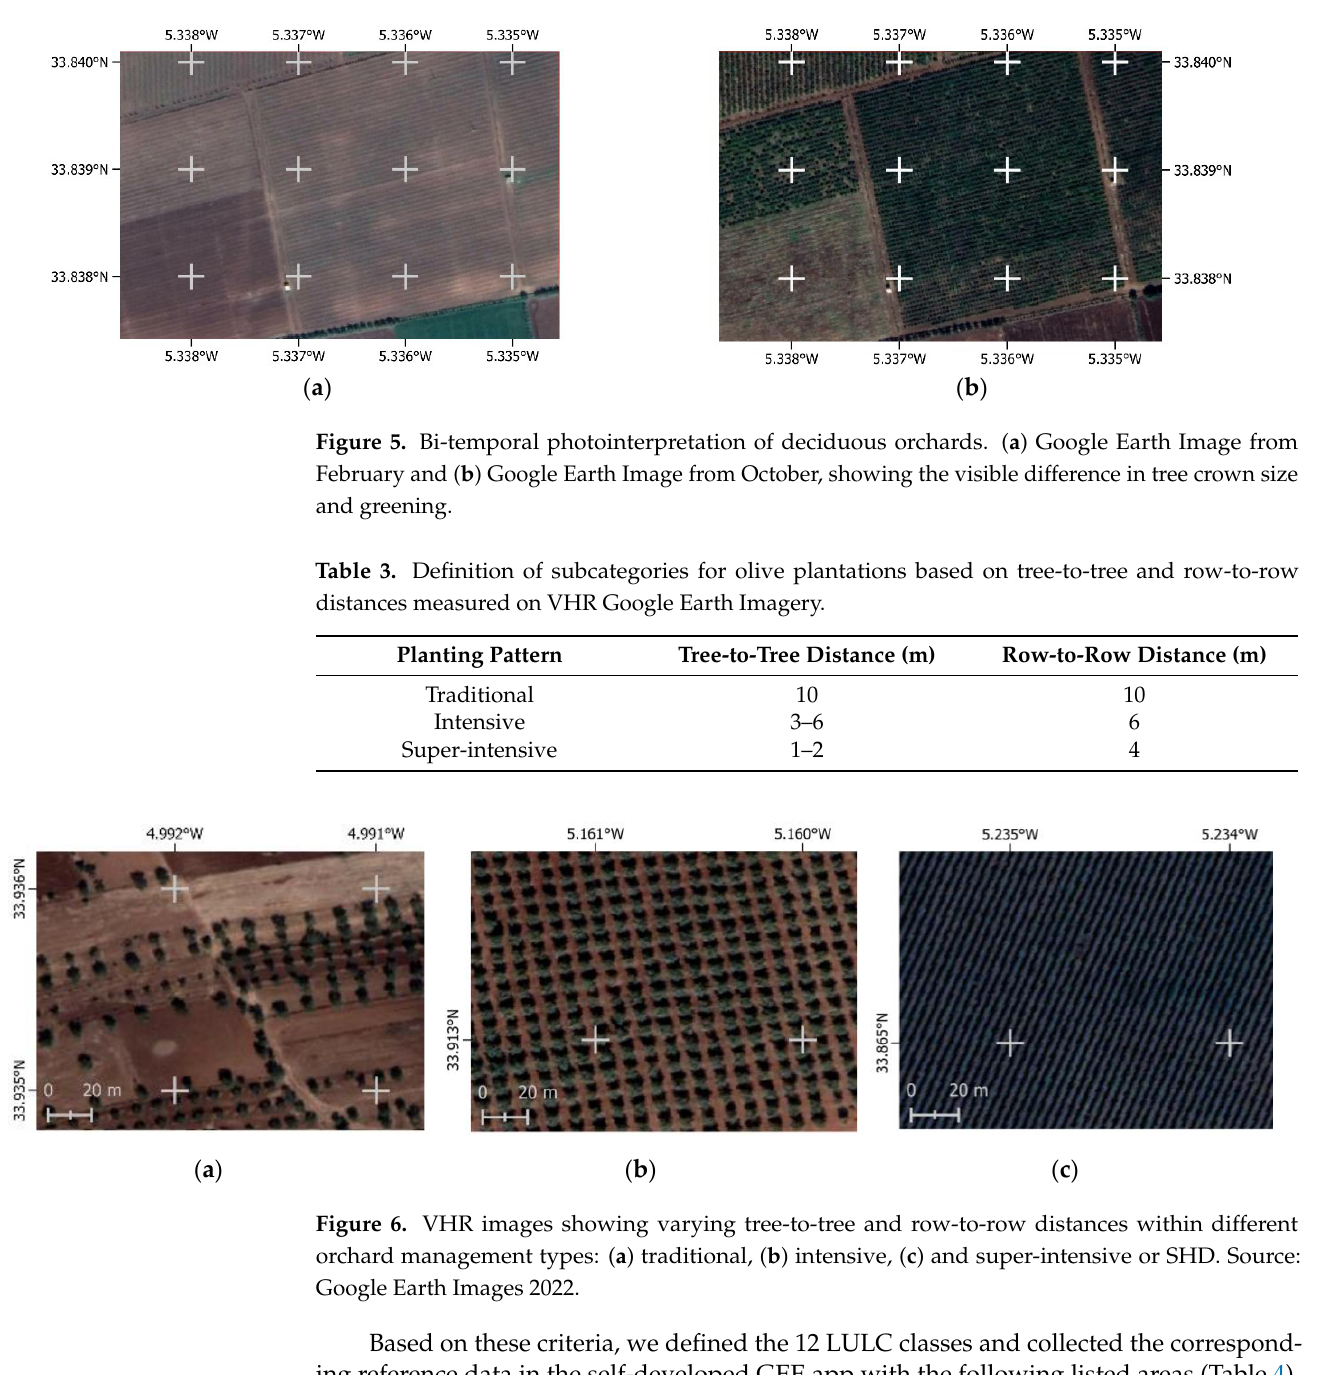
Figure 6. VHR images showing varying tree-to-tree and row-to-row distances within different or- chard management types: ( a ) traditional, ( b ) intensive, ( c ) and super-intensive or SHD. Source: Google Earth Images 2022.